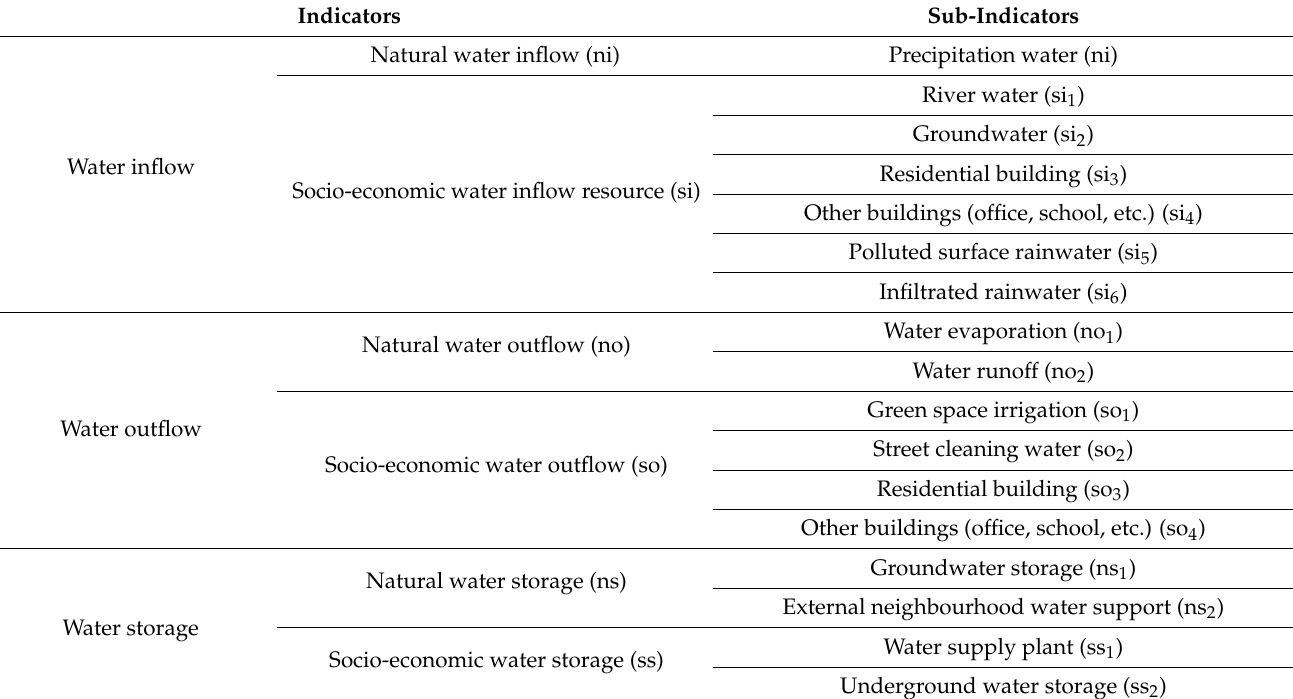
Table 1. Indicators and sub-indicators involved in water